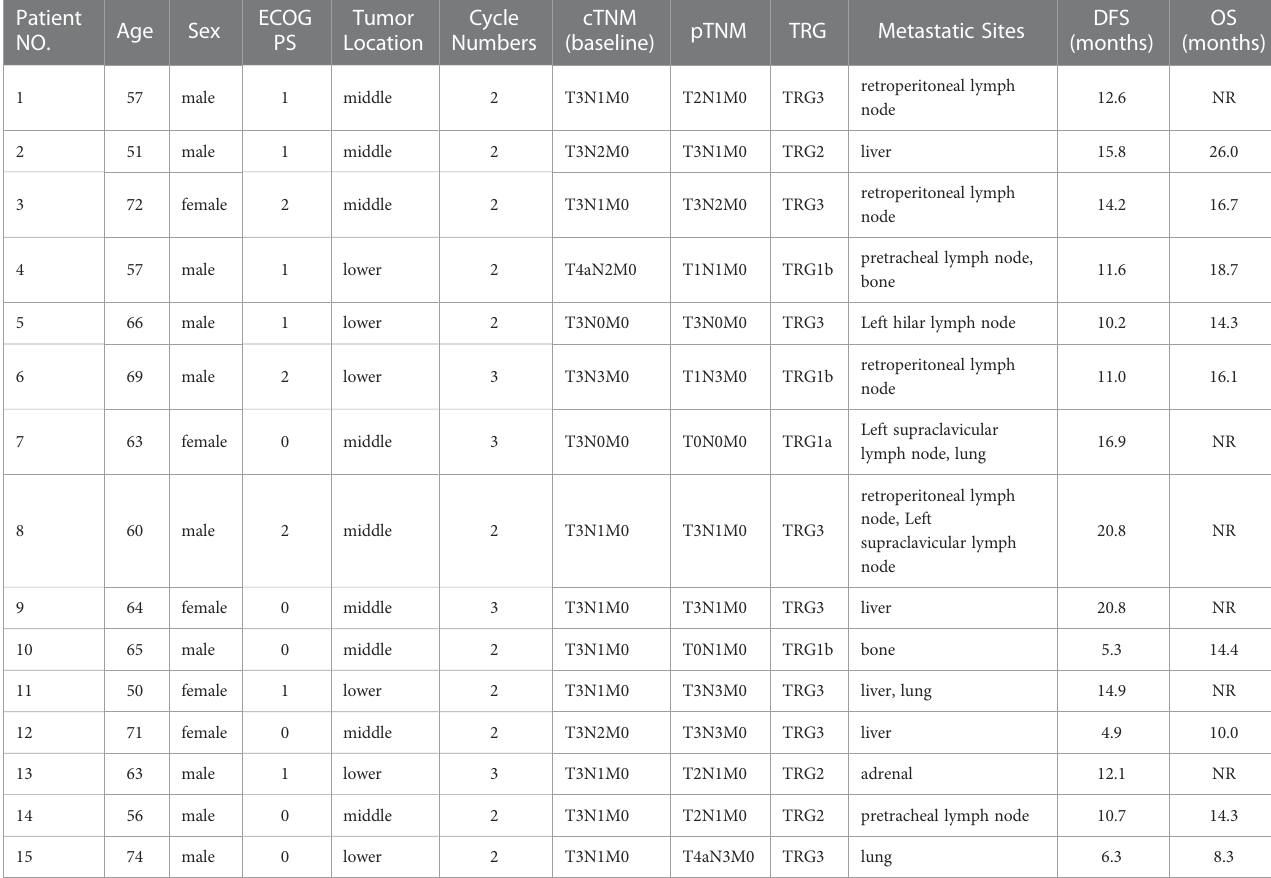
TABLE 3 Characteristics of patients with disease recurrence. Patient